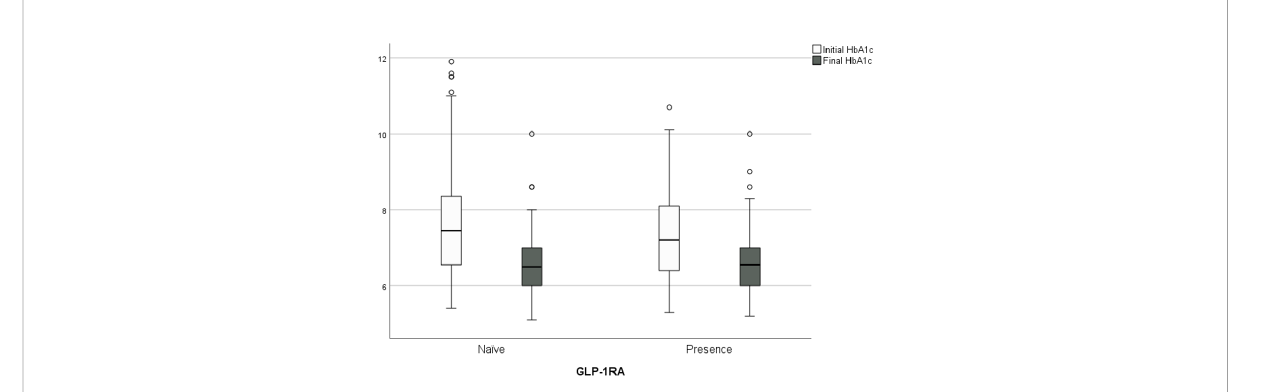
FIGURE 2 Change in HbA1c from baseline to the end of study, 77.8% of GLP- 1 RA- naïve people achieved an HbA1c of <7% at 24 months, as did 76.6% of GLP- 1RA- experienced people, with no signi fi cant difference.